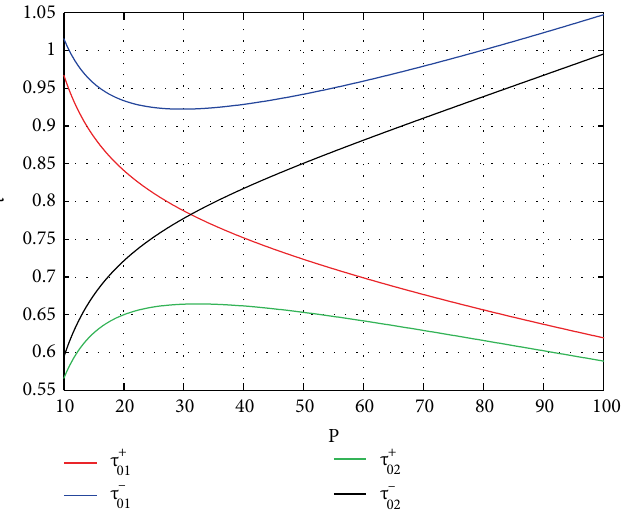
Figure 1: The Hopf bifurcation curves for Equation (5) at the trivial equilibrium (0, 0,0, 0) when 𝑟 = 4/3,𝑐 = 94, and 𝑘 = 0